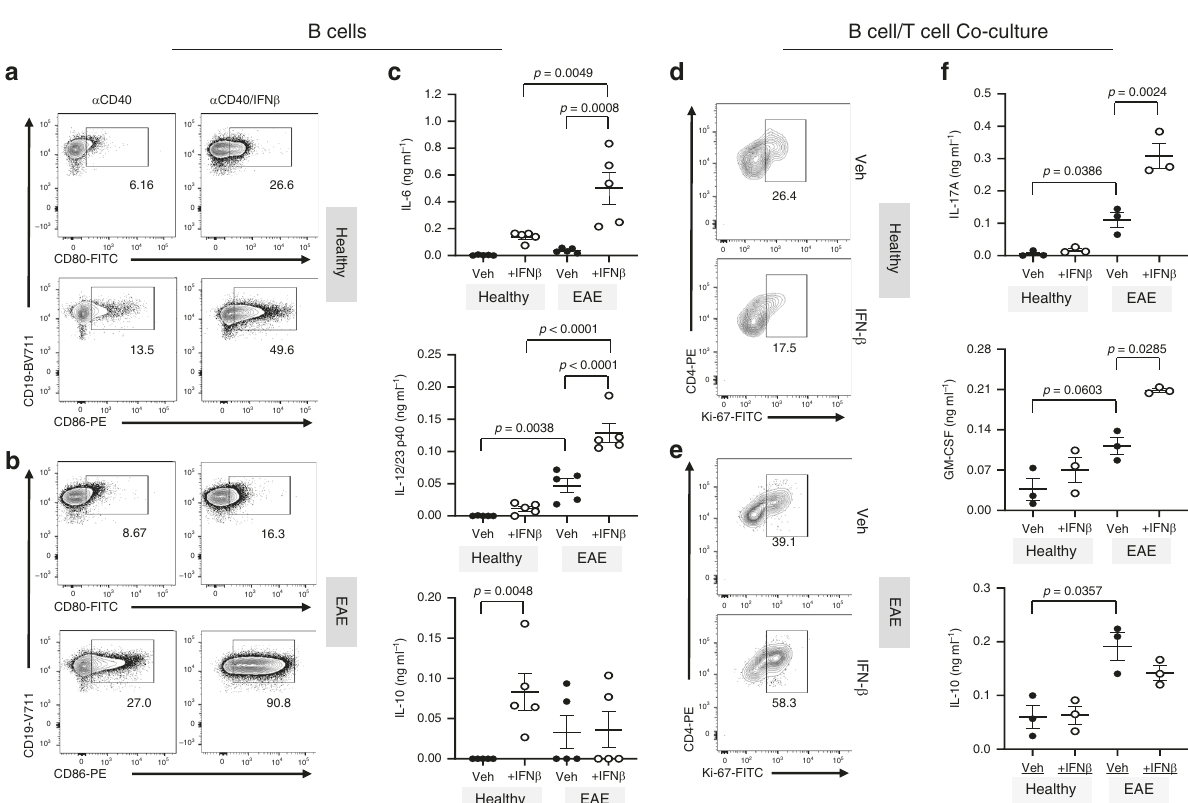
Fig. 9 Effect of IFN- β -stimulated B cells on TH17 cells. Puri fi ed B cells from spleens of healthy or EAE mice ( n = 5) were stimulated with anti-CD40± IFN- β for 3 days. Following stimulation, B cells were washed and co-cultured with CD4 + T cells from 2D2 mice in the presence of MOG 35 – 55 antigen. Following IFN- β stimulation, B-cell phenotype and cytokine production were assessed by a , b FACS and c ELISA, respectively. Stimulated B cells were washed and co- cultured with antigen-speci fi c 2D2 T-helper cells in the presence of MOG 35 – 55 antigen. Representative fl ow cytometry plots of Ki-67 staining of 2D2 CD4 + T cells cultured with B cells from d healthy ( n = 3) or e EAE mice ( n = 3). f The cytokines IL-17A, GM-CSF, and IL-10 from the co-culture supernatants were analyzed by ELISA ( n = 3 per group). Statistical signi fi cance was determined using paired one-way ANOVA tests with multiple comparison corrections using the Holm-Sidak ’ s method. P values < 0.05 were considered signi fi cant. Error bars indicate SEM. Source data are provided as a Source Data fi le.